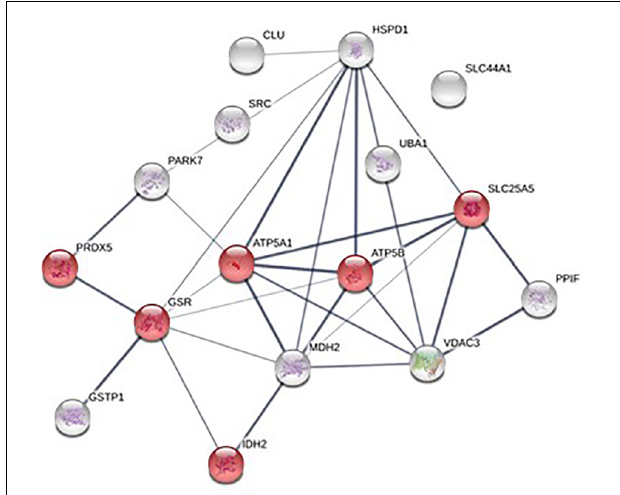
FIGURE 6 | Protein-protein interaction network of the 16 mitochondrial proteins identified in platelet-derived MPs; mitochondrial proteins associated with “Oxidation-reduction processes” are highlighted in red.